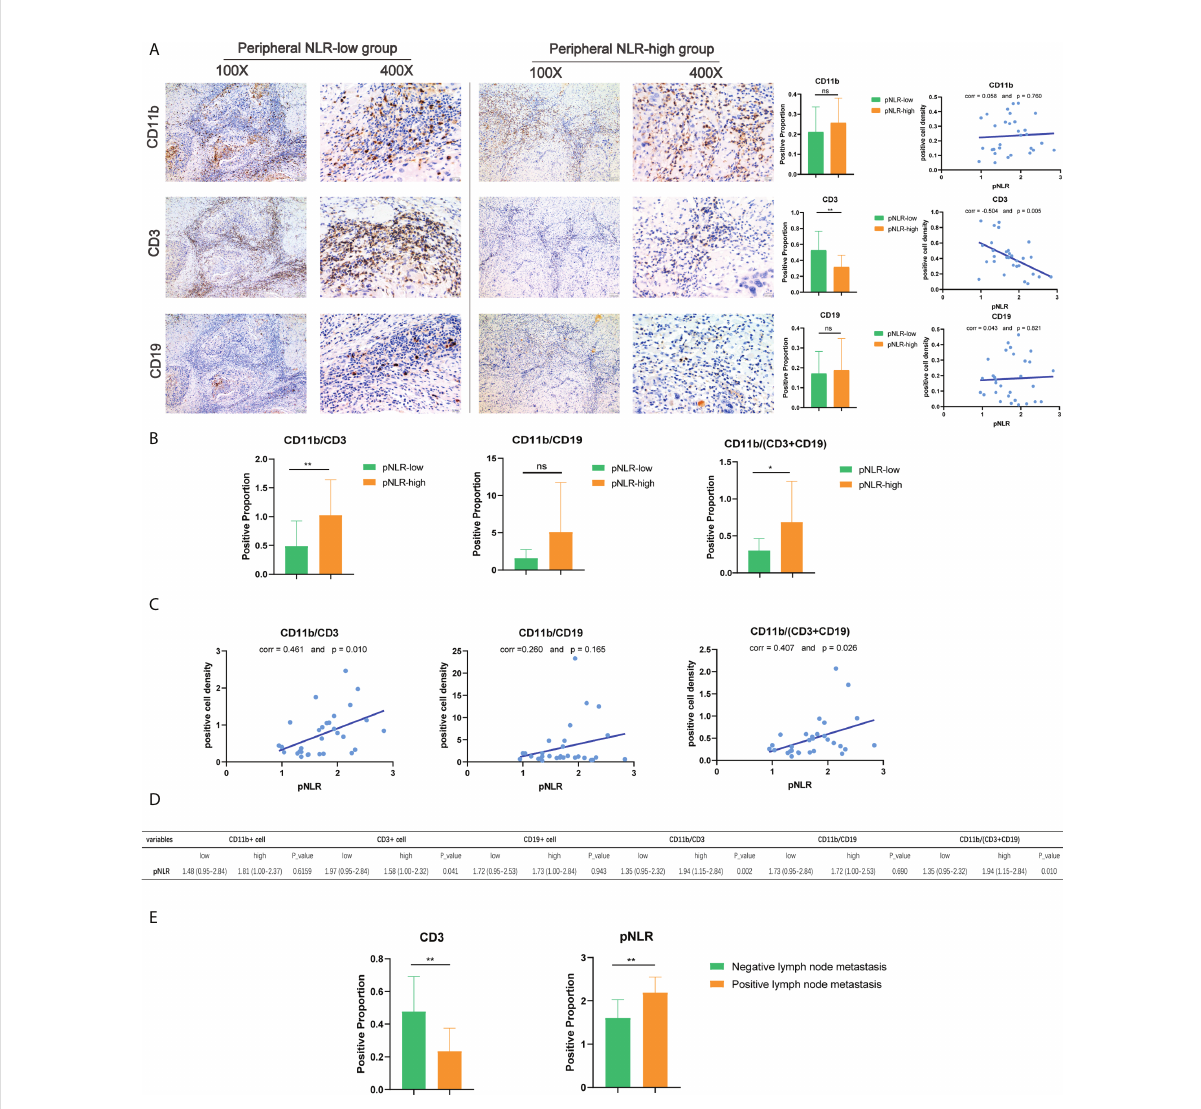
FIGURE 6 Immunohistochemistry (IHC) of CD11b(+), CD3(+), and CD19(+) cell density in HNSCC tissues. (A) Representative images, the Mann – Whitney U test, and Pearson correlation analysis of CD11b(+), CD3(+), and CD19(+) cell density in high-pNLR and low-pNLR groups, presented in ×100 and ×400 magni fi cations. (B) Mann – Whitney U test of CD11b/CD3, CD11b/CD19, and CD11b/(CD3 + CD19) ratios in the tumor tissue between high- and low-pNLR patients. (C) Pearson correlation of tumor-in fi ltrating CD11b/CD3, CD11b/CD19, and CD11b/(CD3 + CD19) ratios and pNLR. (D) Mann – Whitney U test of immune marker expression proportion in the TIME between high-pNLR and low-pNLR patients. (E) Mann – Whitney U test of the high-pNLR and low-tumor-in fi ltrating CD3(+) cell density in the lymph node metastasis group and non-lymph node metastasis group. ns, not signi fi cant, *p ≤ 0.05; **p ≤